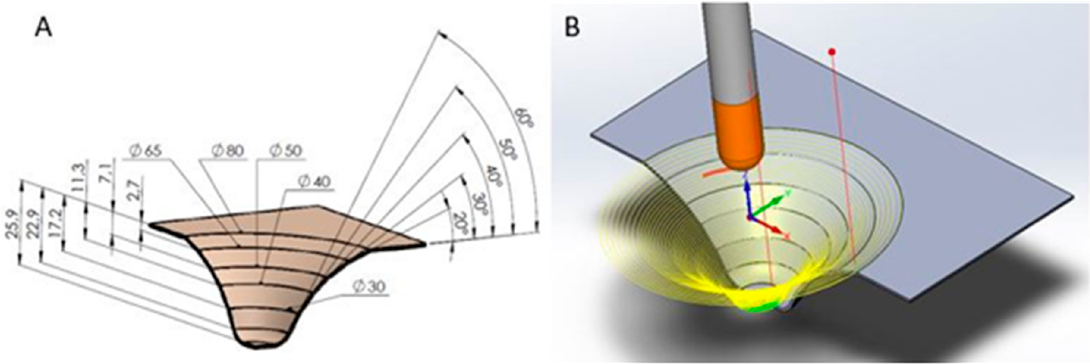
Figure 2. ( A ) Geometry of the cone used in the variable wall angle assays. ( B ) Helical path definition.